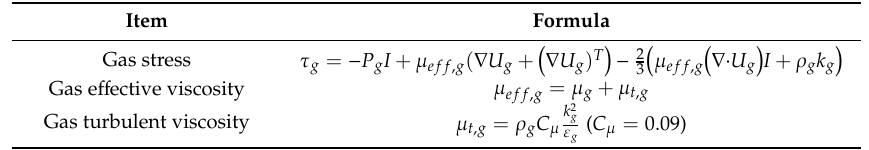
Table 1. Gas constitutive relations.